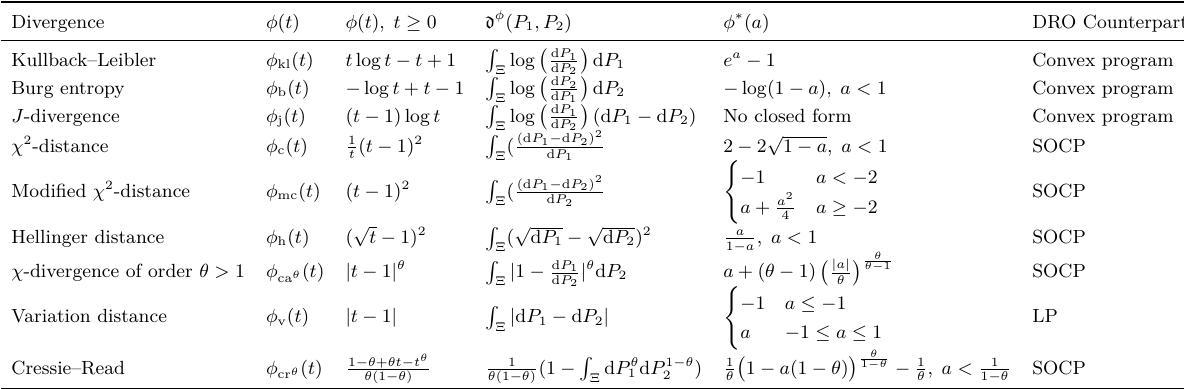
Table 3 Examples of φ -divergence functions, their conjugates φ ∗ ( a ), and their DRO counterparts (see Ben-Tal et al.